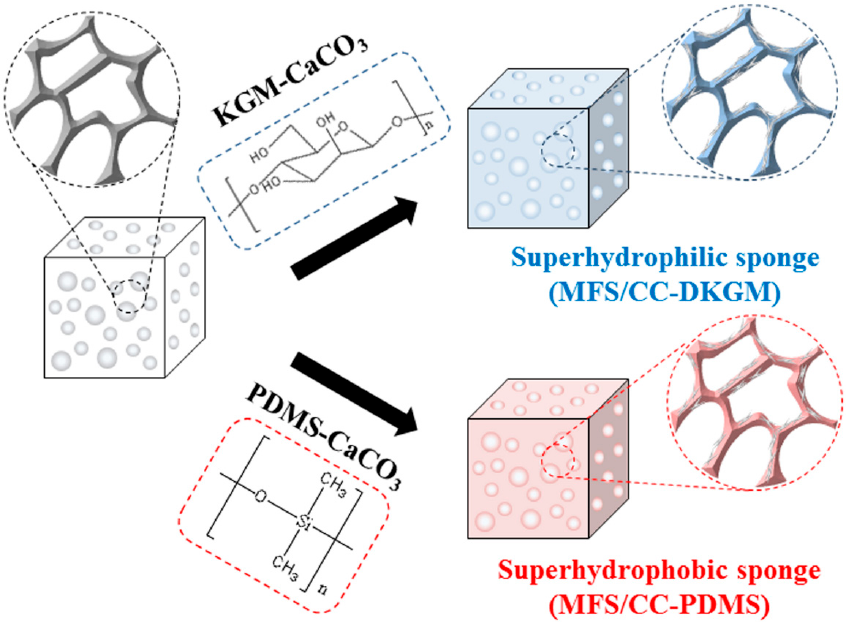
Figure 1. Schematic illustration of the one-step synthesis of environmentally friendly superhydrophilic (MFS/CC-DKGM) and superhydrophobic (MFS/CC-PDMS).